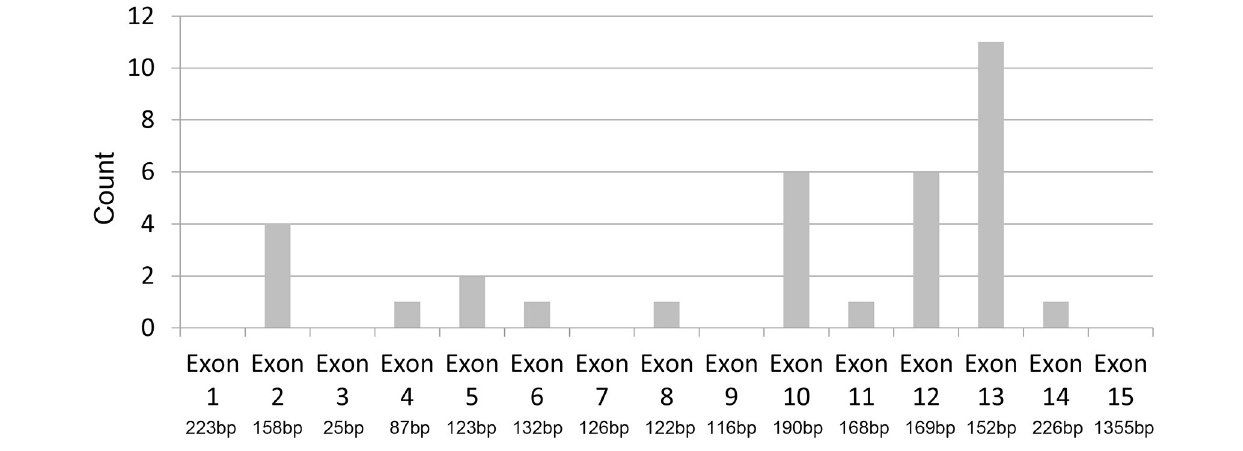
FIGURE 2 | Hot-spot region of protein S mutation. Distribution of PROS1 mutations across exon 1 to 15: 50% (17/34) of the identified mutations occurred in exons 12 and 13.